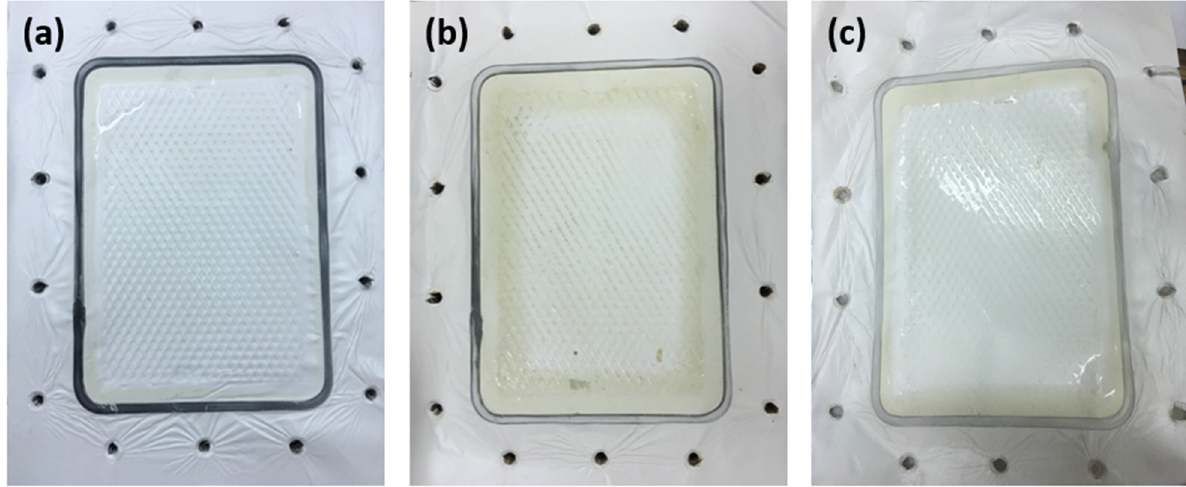
Figure 11. Visual effect of HA foulant on the membrane surface; ( a ) after the first wash with DI feed, ( b ) application of HA feed, ( c ) washing the foulant off the membrane using DI feed.